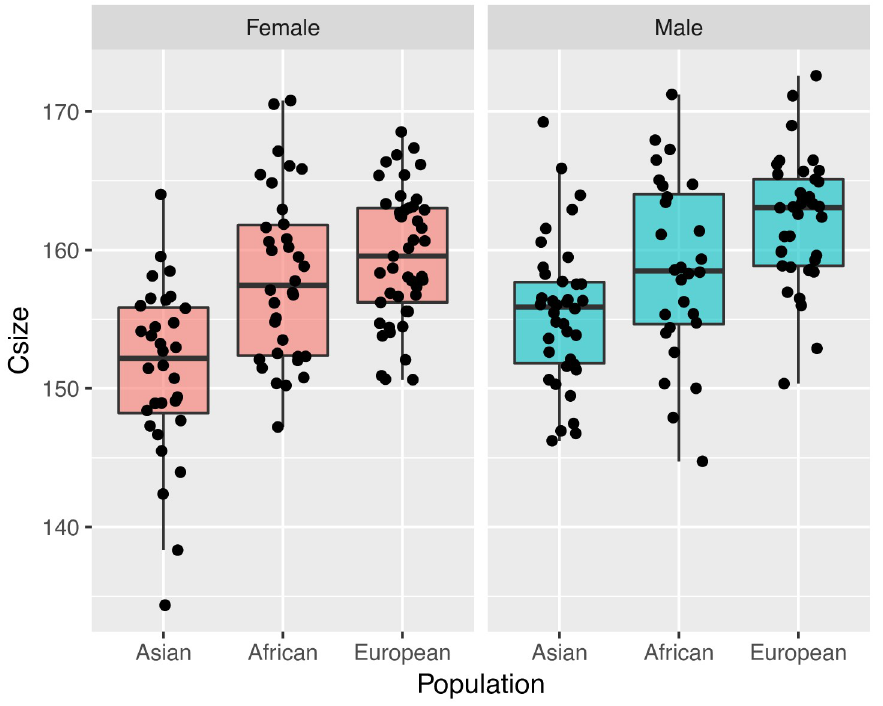
Fig 6. Plot of centroid size in different sexes and